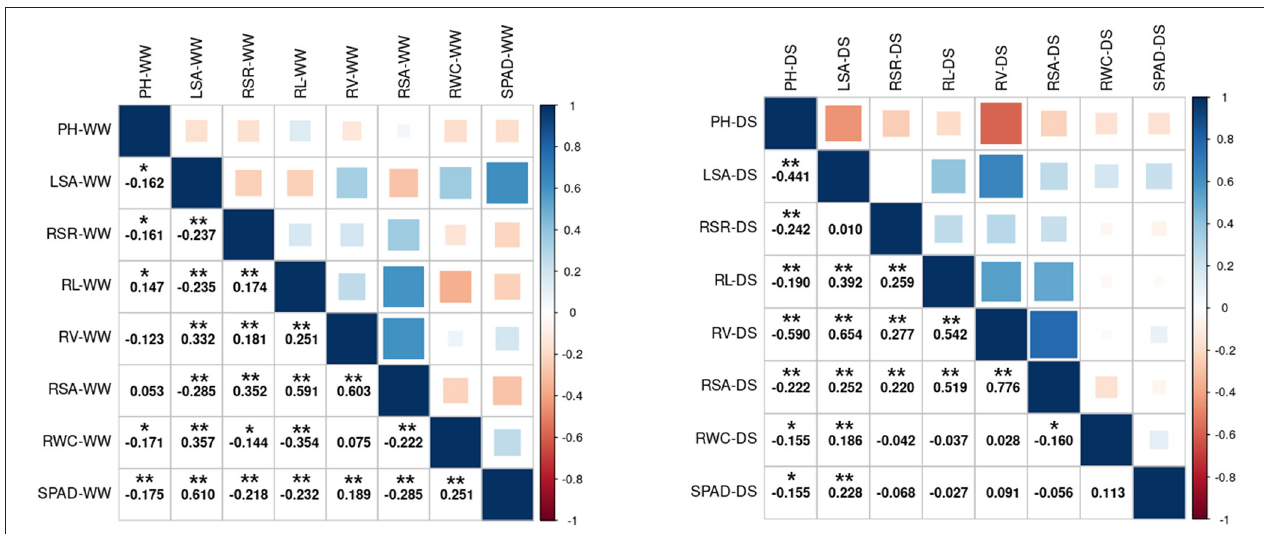
FIGURE 2 | Spearman’s correlation analysis between the 8 drought-related traits under two water condition. Left: Under WW growth condition. Right: Under DS growth condition. WW, well-water growth condition; DS, drought-stress growth condition; PH, plant height; LSA, leaf surface area; RSR, Root shoot ratio; RL, Root length; RV, Root volume; RSA, Root surface area; RWC, Relative water content; SPAD, SPAD value. * and **Significant at the 0.05 and 0.01 probability levels between genotypes, respectively.